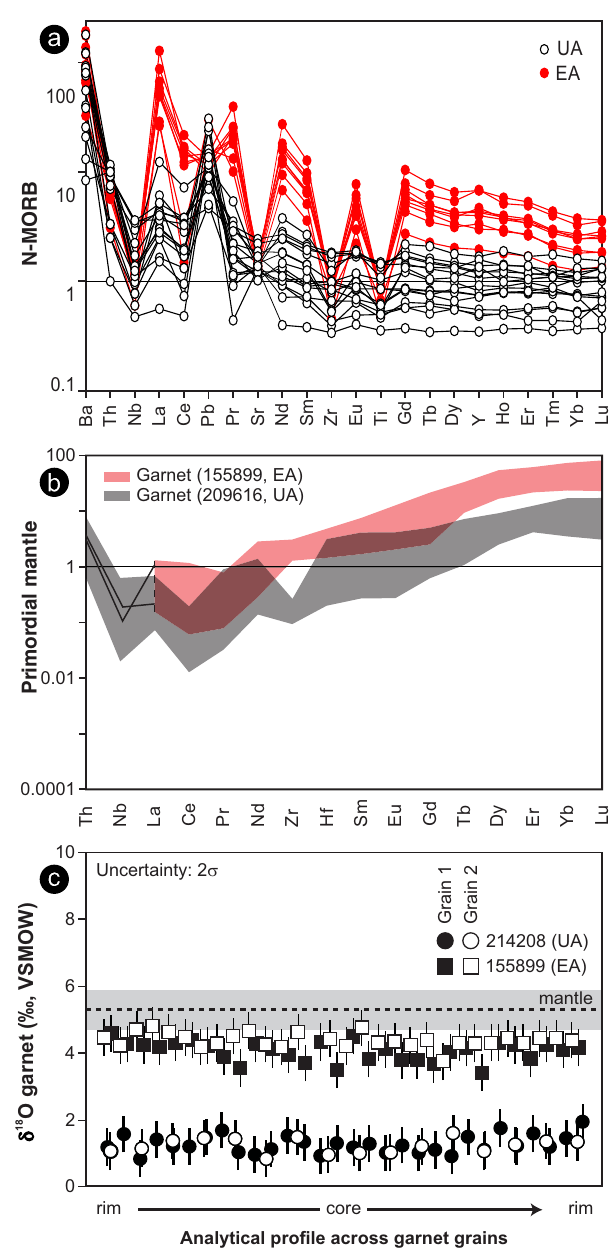
Fig. 5 | Trace-element and O-isotope compositions of amphibolite from the Waroonga greenstone belt. a Normal mid-ocean ridge basalts (N-MORB) nor- malized incompatible trace-element patterns of the garnet amphibolite, showing the distinctive differences in rare Earth elements (REE), large ion lithophile ele- ments (LILE), Th and, in particular, high fi eld strength elements (HFSE), in the EA group. b Mantle-normalised incompatible trace-element patterns of garnet in UA and EA. Compared with UA, EA garnets show strong enrichments in REE, without enrichment in Nb (only two analyses, both shown as traces, with Nb above detec- tion) or Th. c Secondaryionmass spectrometer(SIMS) δ 18 O analysesacross garnet grains of sample 214208 and 155899. The grey bar shows the mantle δ 18 O range 44